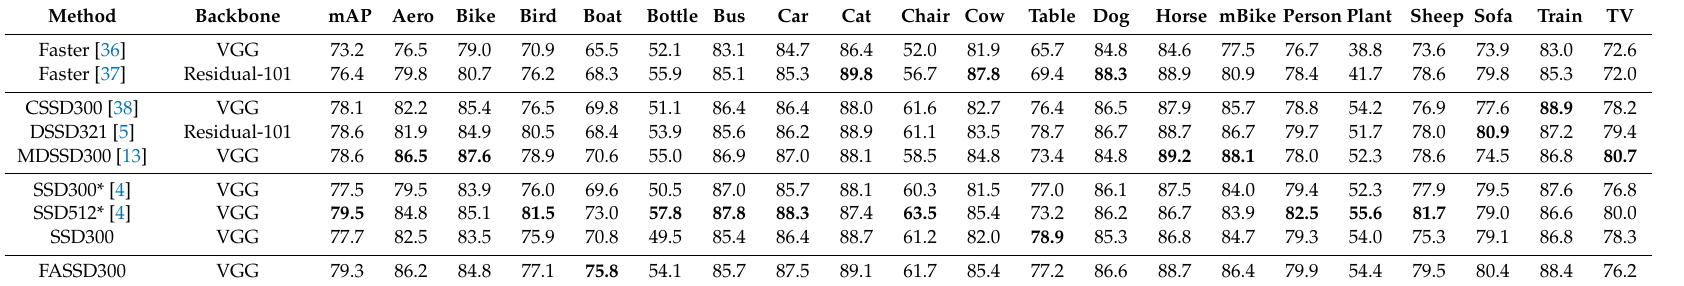
Table 4. Results on PASCAL VOC2007